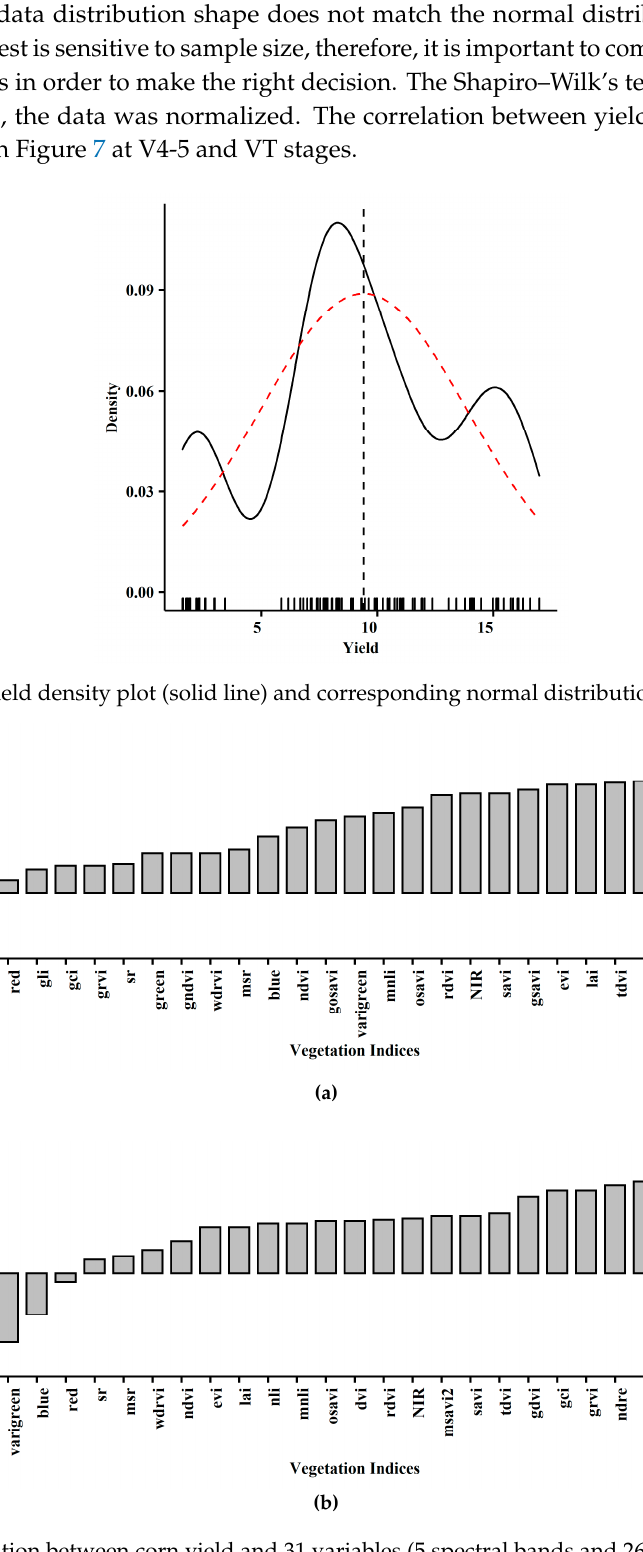
Figure 7. correlation between corn yield and 31 variables (5 spectral bands and 26 vegetation indices (VIs): ( a ) at V4-5 (4-5 leaves with visible leaf collar); ( b ) at tasseling stage (VT).